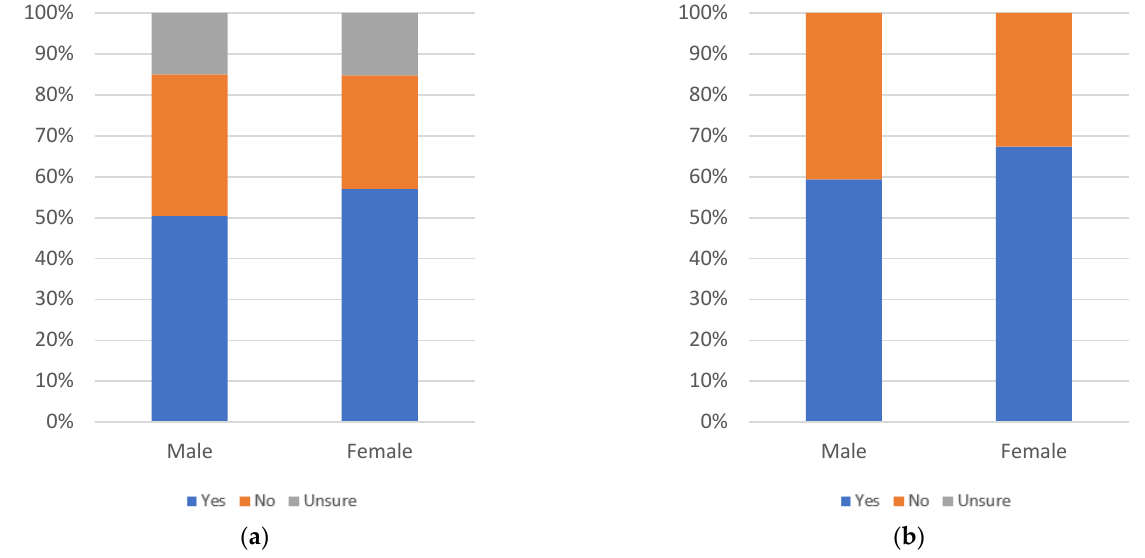
Figure 99. Label trustworthiness judging use, by gender: ( a ) with uncertain respondents (left) and ( b ) without uncertain respondents (right).